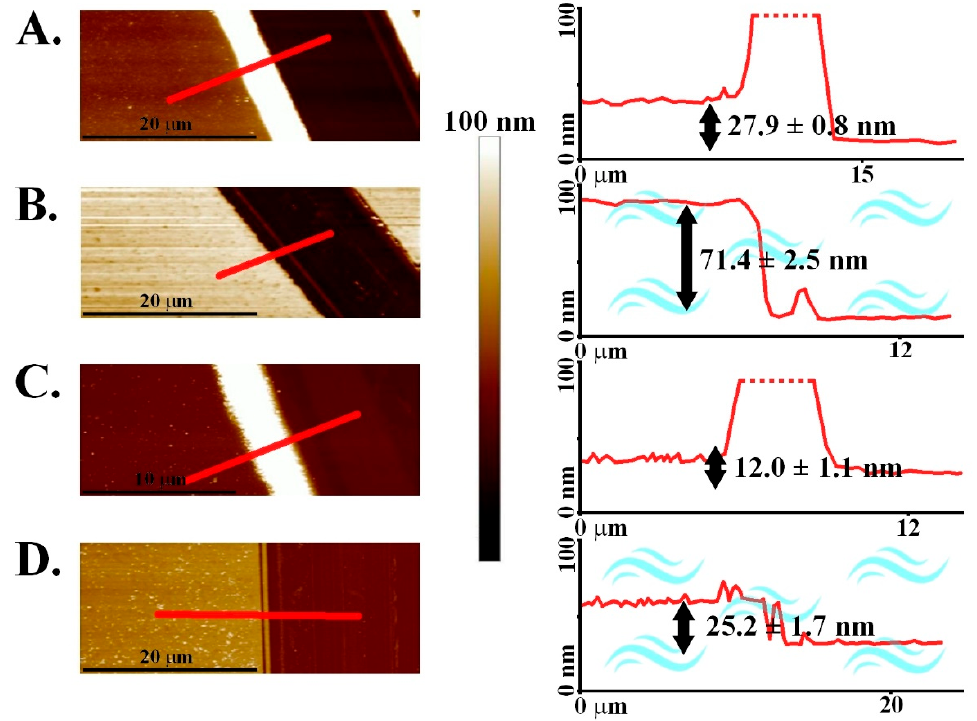
Figure 1. Atomic force microscopy (AFM) topography images of the brushes with the corresponding cross-sections: ( A ) (poly(APTAC) in the air, ( B ) poly(APTAC) in the water, ( C ) poly(APTAC)+SPIONs in the air, ( D ) poly(APTAC)+SPIONs in the water.